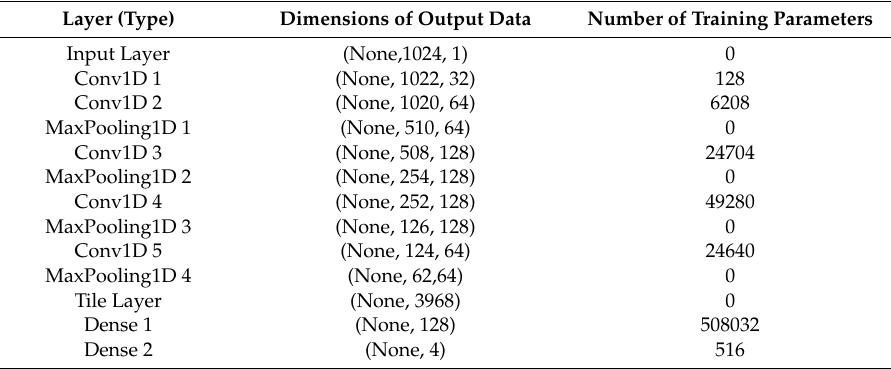
Table 1. 1D CNN single-point reciprocating compressor gas valve fault diagnosis model